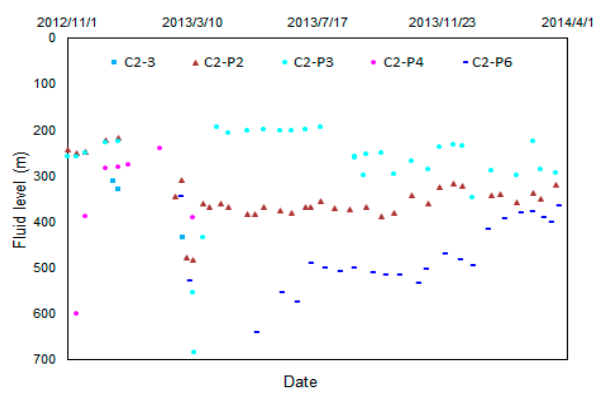
Figure 38. Working fluid level of the effective wells.